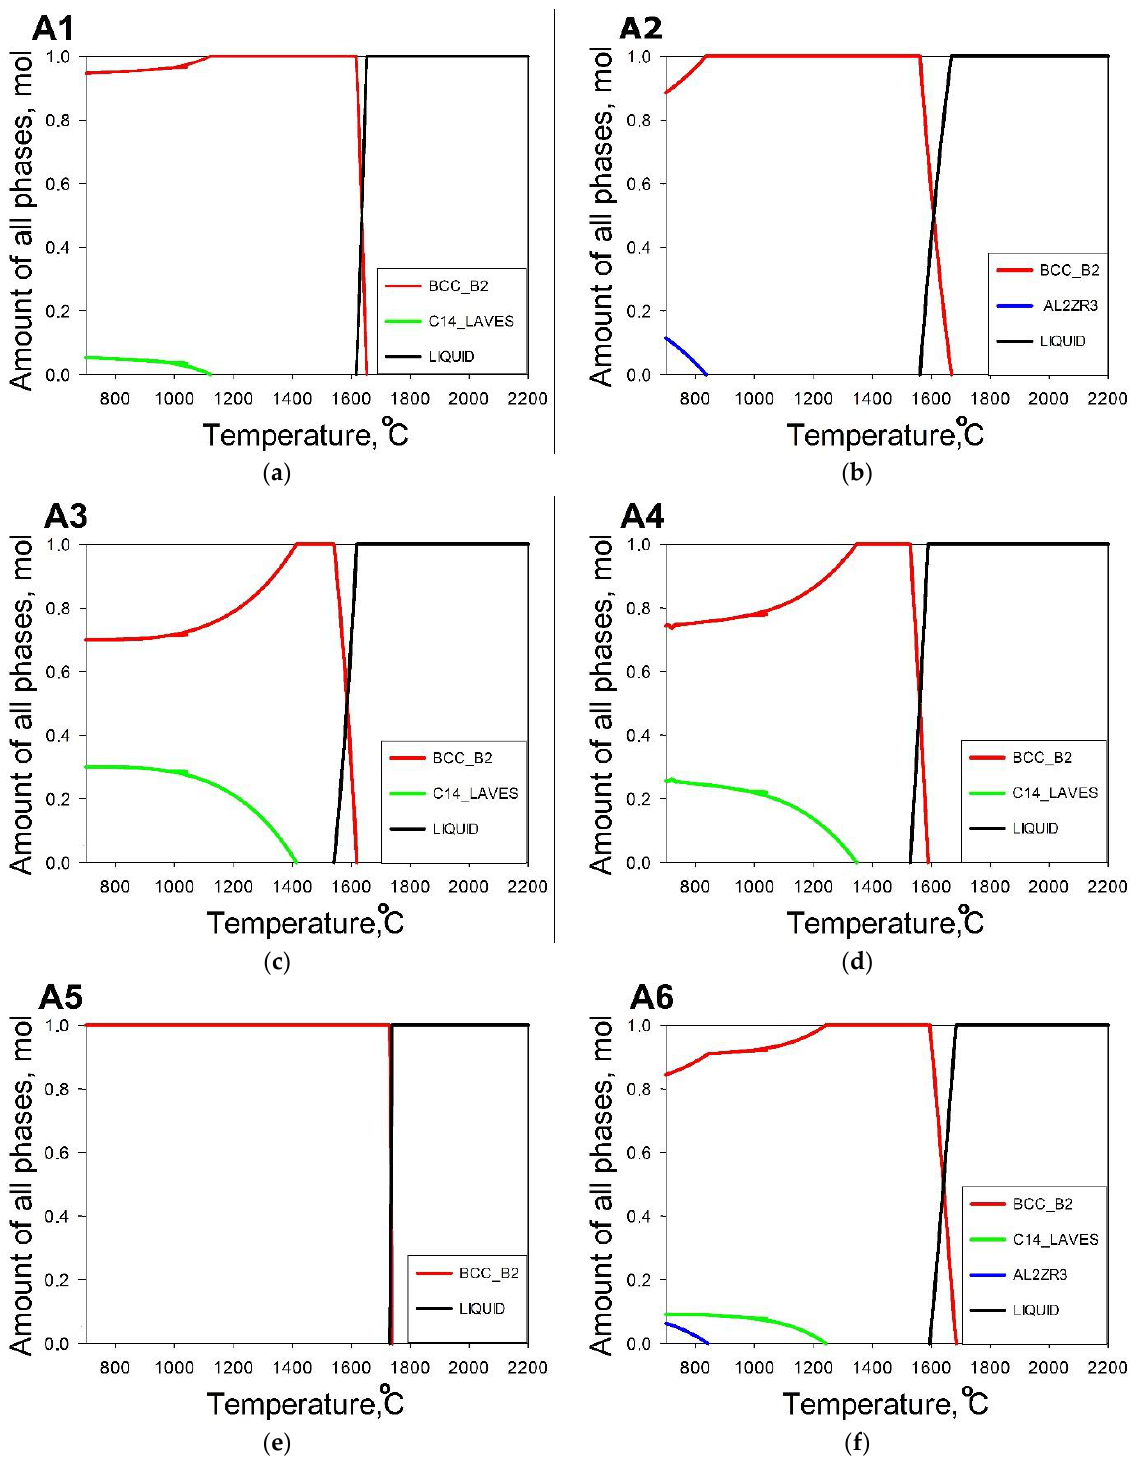
Figure 8. Calculated phase diagrams for the model alloys A1 ( a ), A2 ( b ), A3 ( c ), A4 ( d ), A5 ( e ) and A6 ( f